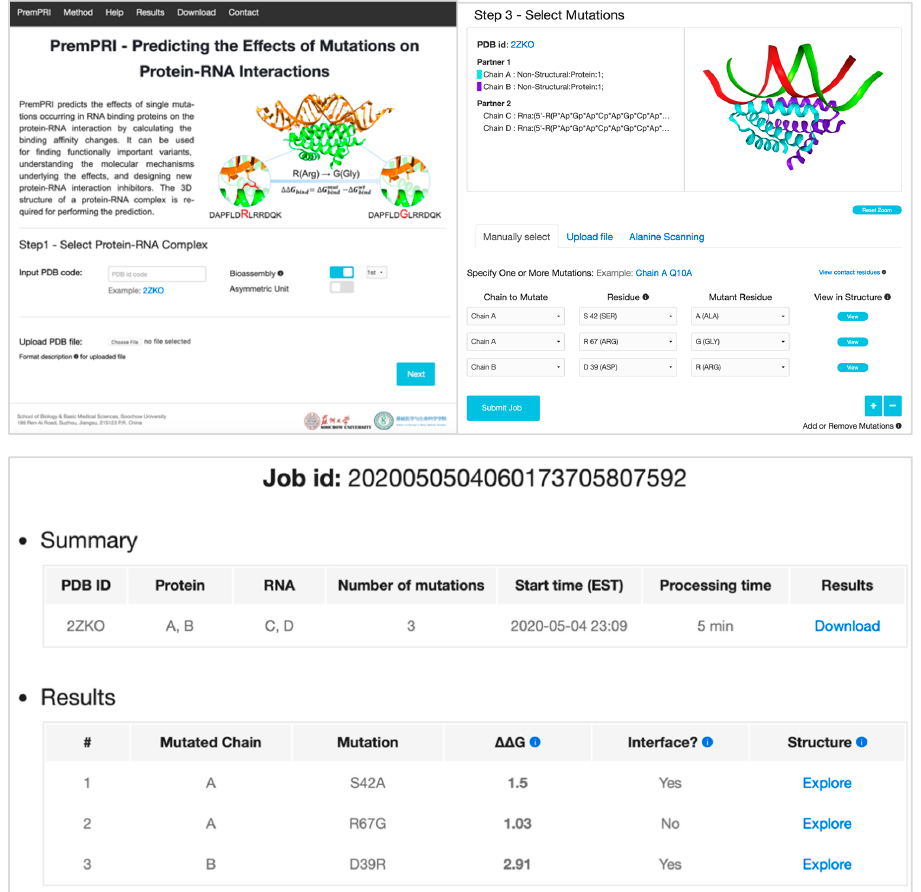
Figure 3. Left corner: the entry page of PremPRI server; right corner: the third step for selecting mutations and three options are provided: “Specify One or More Mutations Manually”, “Upload Mutation List” and “Alanine Scanning for Each Chain”, see also Figure S3; and bottom: final results, see also Figure S4. “Processing time” refers to the running time of a job without counting the waiting time in the queue.